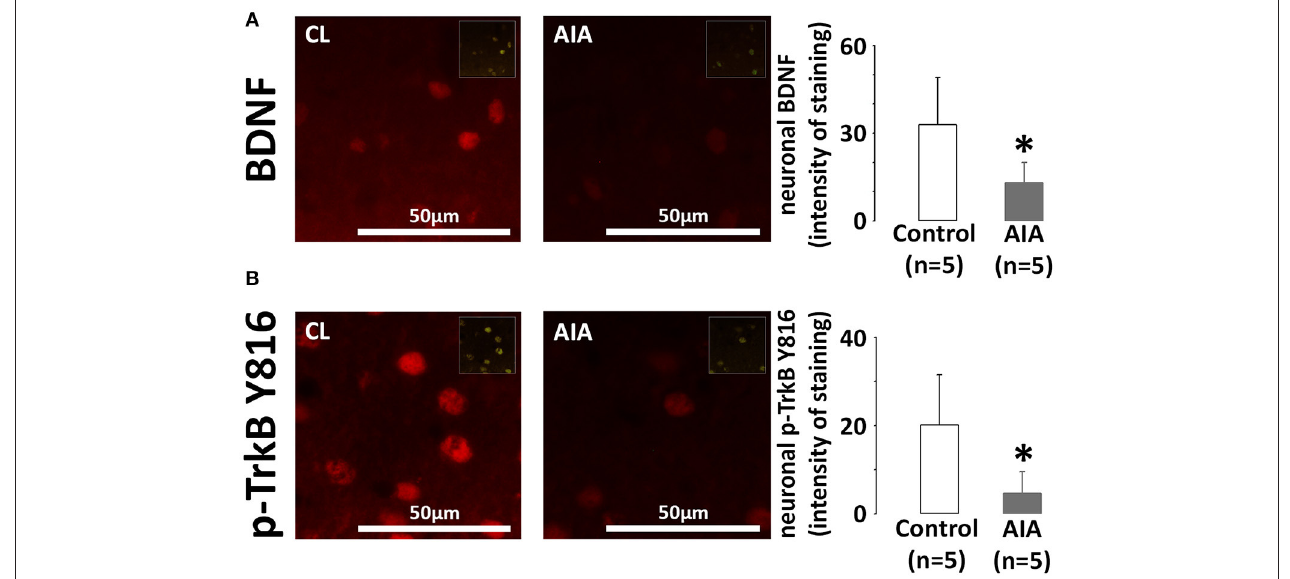
FIGURE 1 | (A) Effect of AIA on neuronal BDNF expression using immunohistochemical analysis of brain slices. Representative photographs of BDNF (red) labeling in neurons of the CA1 hippocampal region and quantification of staining intensity, (B) Effect of AIA on neuronal p-TrkB Y816 receptors expression (see legend A). NeuN was used as a neuronal marker (merged images in inserts). Brain samples were collected at day 31 ± 2 post-immunization. Values are expressed as means ± SD, n = number of rats, * p < 0.05 vs. control rats.